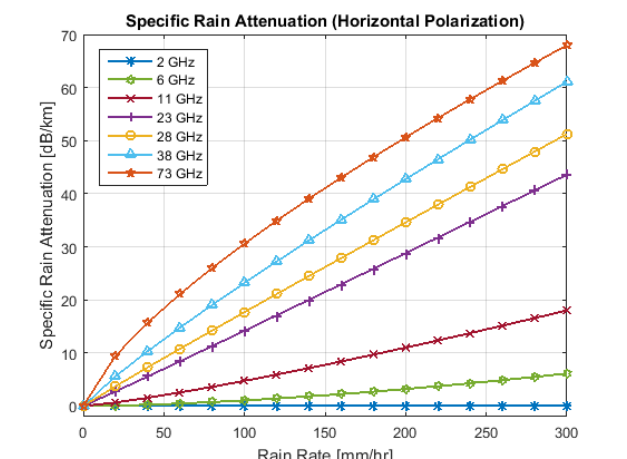
Fig 31. Specific Rain Attenuation (Horizontal Polarization)